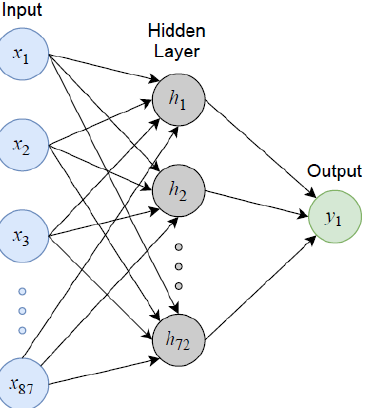
Figure 1. Schematic representation of the final selected MLP architecture, consisting of one hidden layer (72 nodes) arranged sequentially between the input (87 feature nodes) and output (1 target node) layers. The input features correspond to the elemental, mineralogical and gold-related variables in the generated dataset, less gold recovery, which was retained as the lone target output variable. Details on selection of the number of nodes in the hidden layer are available in Appendix B (Section B . 3).